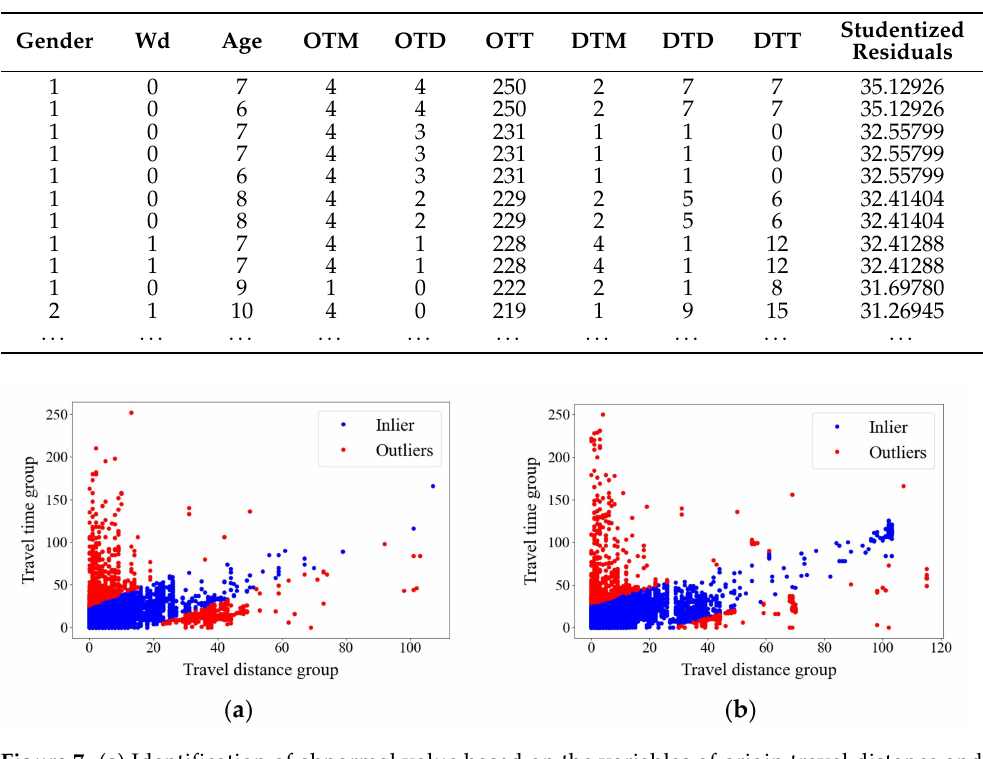
Figure 7. ( a ) Identification of abnormal value based on the variables of origin travel distance and time (May 2019); ( b ) Identification of abnormal value based on the variables of origin travel distance and time (May 2021).